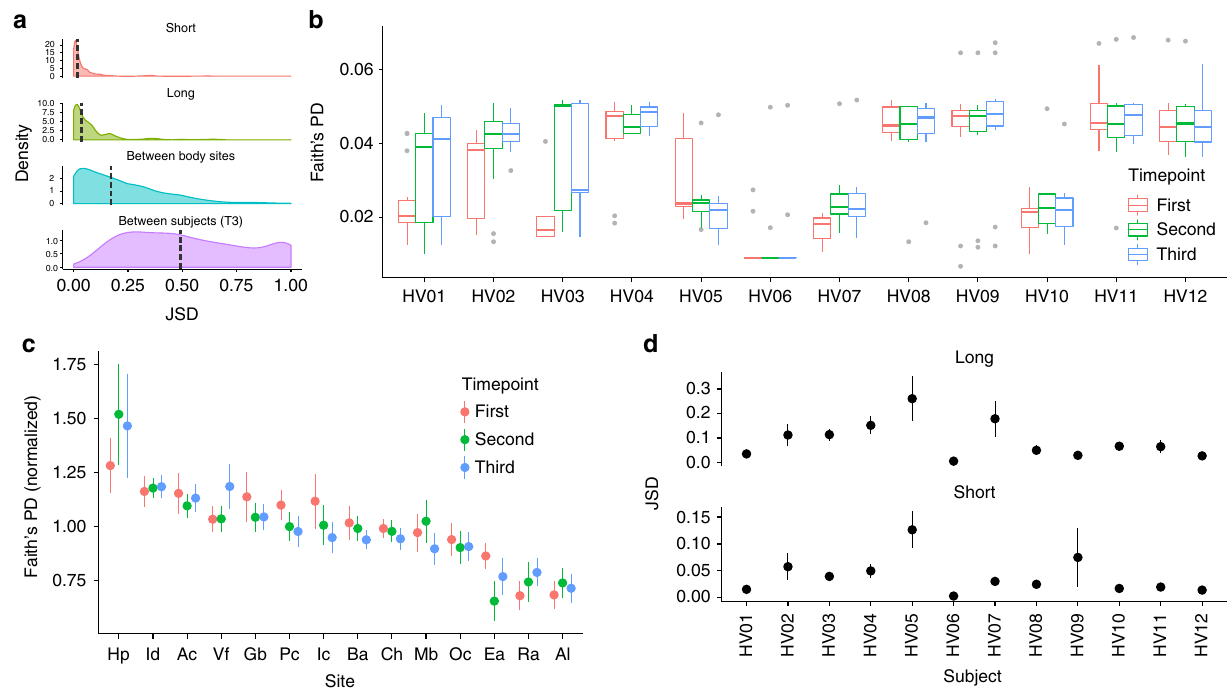
Fig. 4 Diversity and richness of P. acnes in the human skin data set. a Short: for each subject/site pair, we computed the distribution of the JSD between the second and the third time point. Long: the same distribution computed between the fi rst and the second time point. Between body sites: the JSD distribution computed between body sites for each subject/time point pair. Between subjects (T3): for each site, the distribution was computed between subjects at the third time point. Vertical dashed lines represent the median values. b Using the predictions of StrainEst, we could give an estimate of the diversity of the subject-speci fi c P. acnes populations using Faith ’ s phylogenetic diversity (PD) index. Two different phenotypes could be identi fi ed, with high (HV04, HV08, HV09, HV11, and HV12) and low (HV07 and HV10) PD. Three individuals (HV01, HV02, and HV03) switched between low and high phenotype during the course of the study, while one (HV05) switched from high to low PD. Boxes extend to the fi rst and third quartile, whiskers extend to the upper and lower value within 1.5*IQR from the box. Outliers are shown as points. c Faith ’ s PD computed for each site and normalized per subject highlights more diverse (such as Hp) and less diverse environments (Ea, Ra, and Al). d Long: JSD between samples from each individual between the fi rst and second timepoints. Short: the same, between the second and the third timepoints. This individual-speci fi c temporal variability analysis of the P. acnes population shows that subjects (e.g., HV01) that are stable in the fi rst interval tend to maintain these characteristics also in the second, while individuals that are characterized by high variability (e.g., HV05) in the fi rst interval are highly variable also in the following time frame. For c and d , points indicate the mean values, error bars the standard